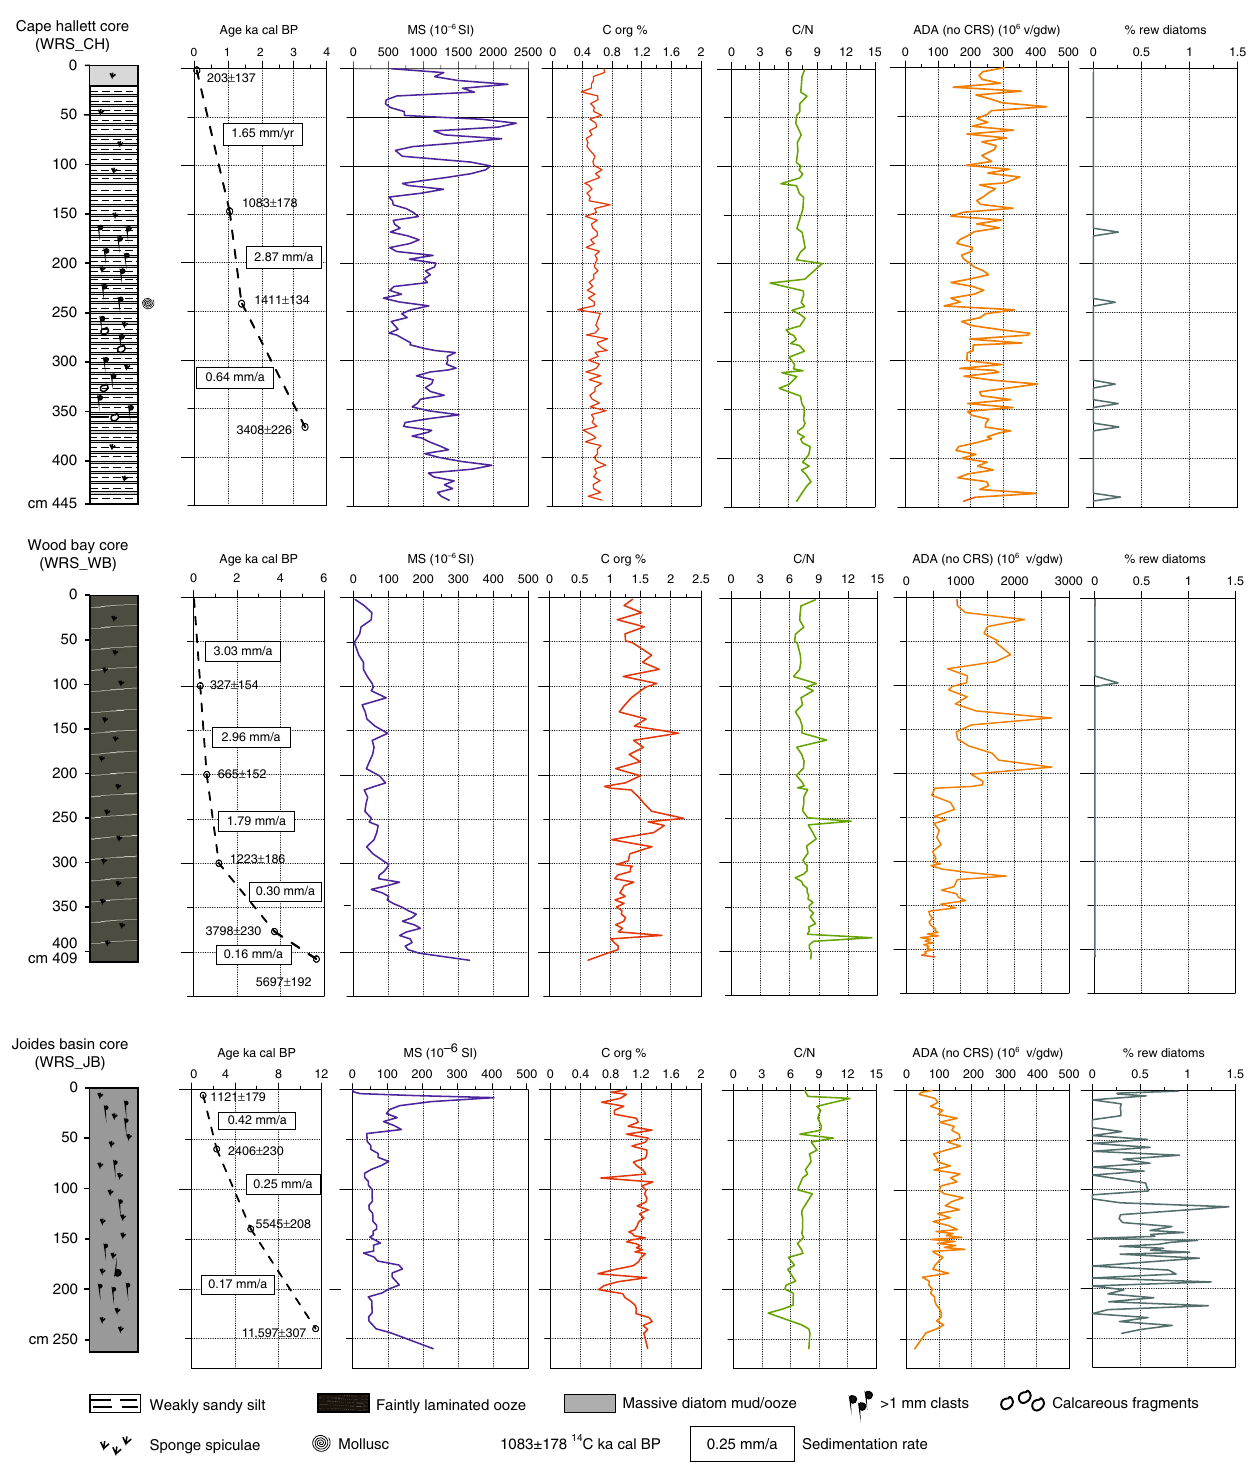
Fig. 7 Marine core lithology and chronology. From top to bottom: description of cores WRS_CH, WRS_WB and WRS_JB showing from left to right, lithology, ages of radiocarbon-dated levels and sedimentation rates, magnetic susceptibility (MS), organic C content (C org %), organic C/total N molar ratio (C/N), absolute diatom abundance (ADA) expressed in number of valves per gram of dry weight (v/gdw), and percentage of reworked diatoms (% rew diatoms). The ADA has been calculated excluding the Chaetoceros resting spore